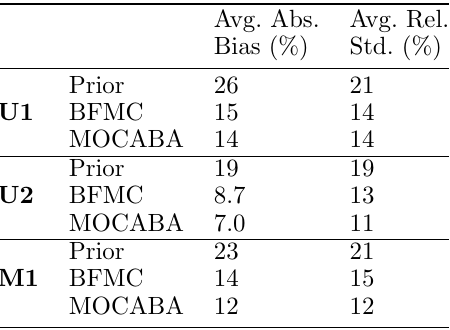
Table 4. Average absolute value of the bias and average relative standard deviation of posterior calculated nuclide concentrations. The C values used in the bias